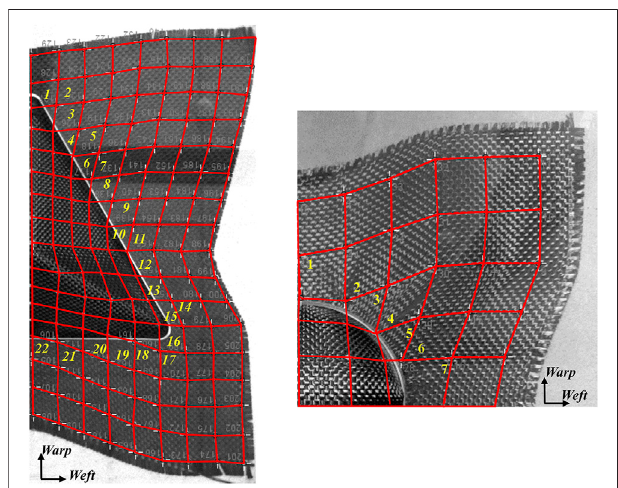
FIGURE 4 | Iamges of half view of formed fabric in tetrehedron forming (left) and quarter view of hemisphere forming (right). White dots on fabrics are joint by red lines to form cells contraining a number of fabric unit cells. Measuring cells are mark with